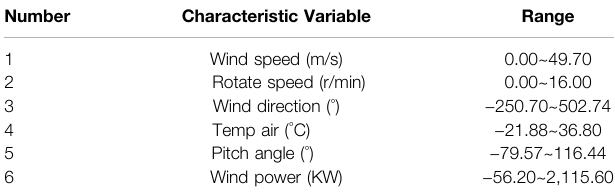
TABLE 1 | Original characteristic variable range of wind